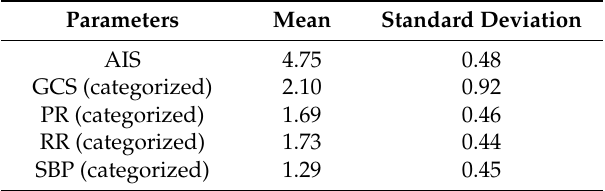
Table 10. Provides the mean and standard deviation of AIS and categorized Glasgow comas